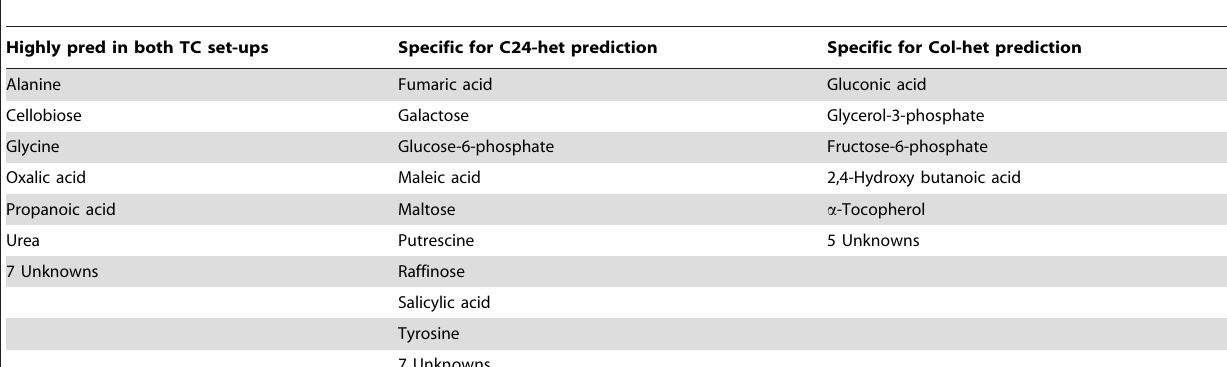
Table 2. Metabolic markers highly predictive (pred) in both testcross (TC) populations and those specifically for heterosis (het) prediction in one certain testcross set-up, each in alphabetical order.